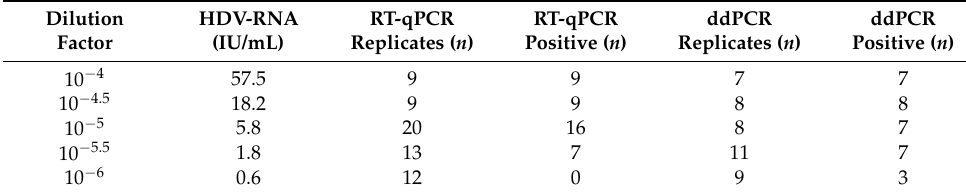
Table 3. Probit regression data.